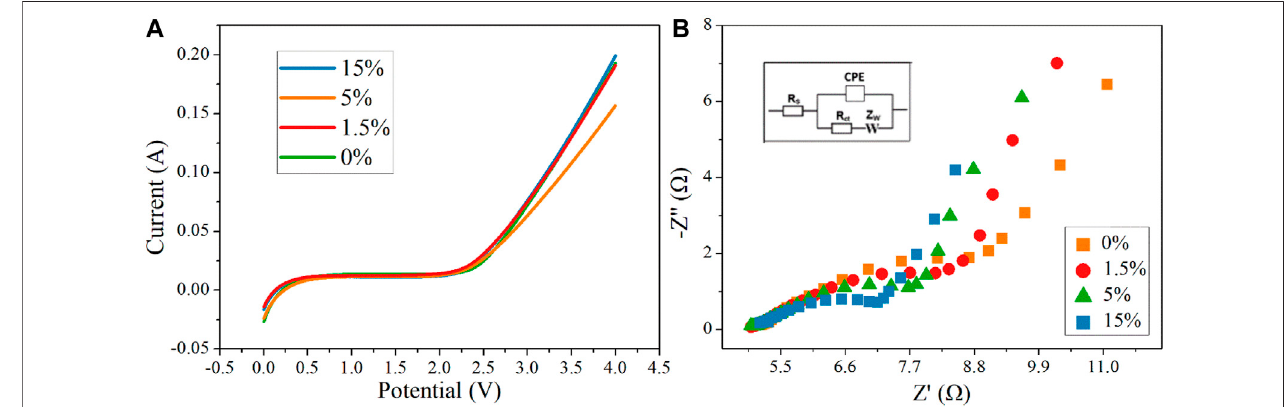
FIGURE 9 | LSV (A) and EIS (B) curves of REMs.